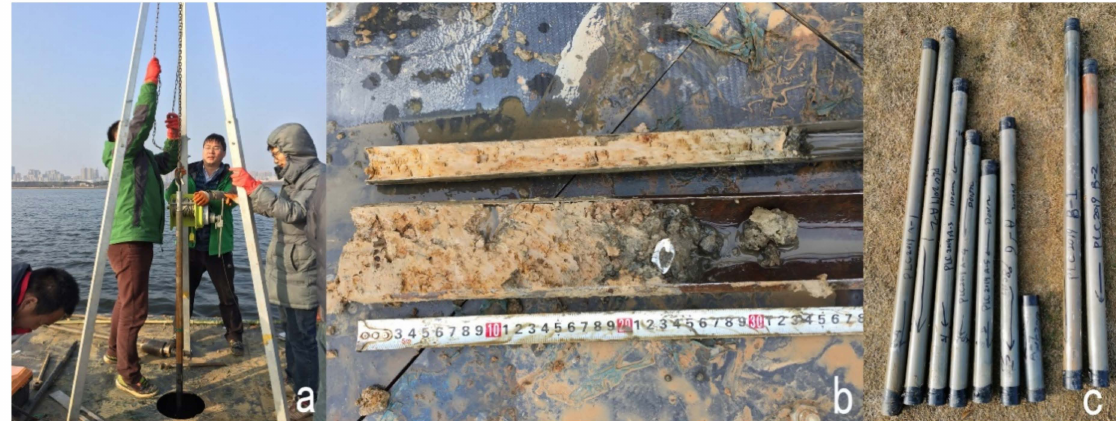
Figure 6. ( a ) Drilling work in progress and using the piston sampler to collect samples from the lake bottom. ( b ) The holes containing cultural remains from the early Shang period. ( c ) The samples sealed in PVC tubes.